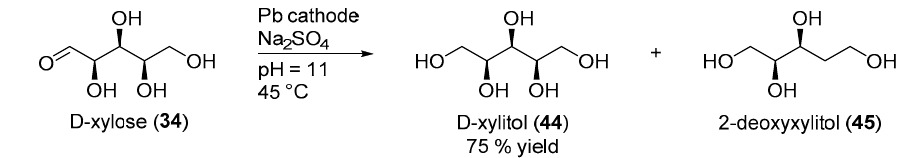
Scheme 23. Electrochemical reduction of D -xylose ( 34 ).